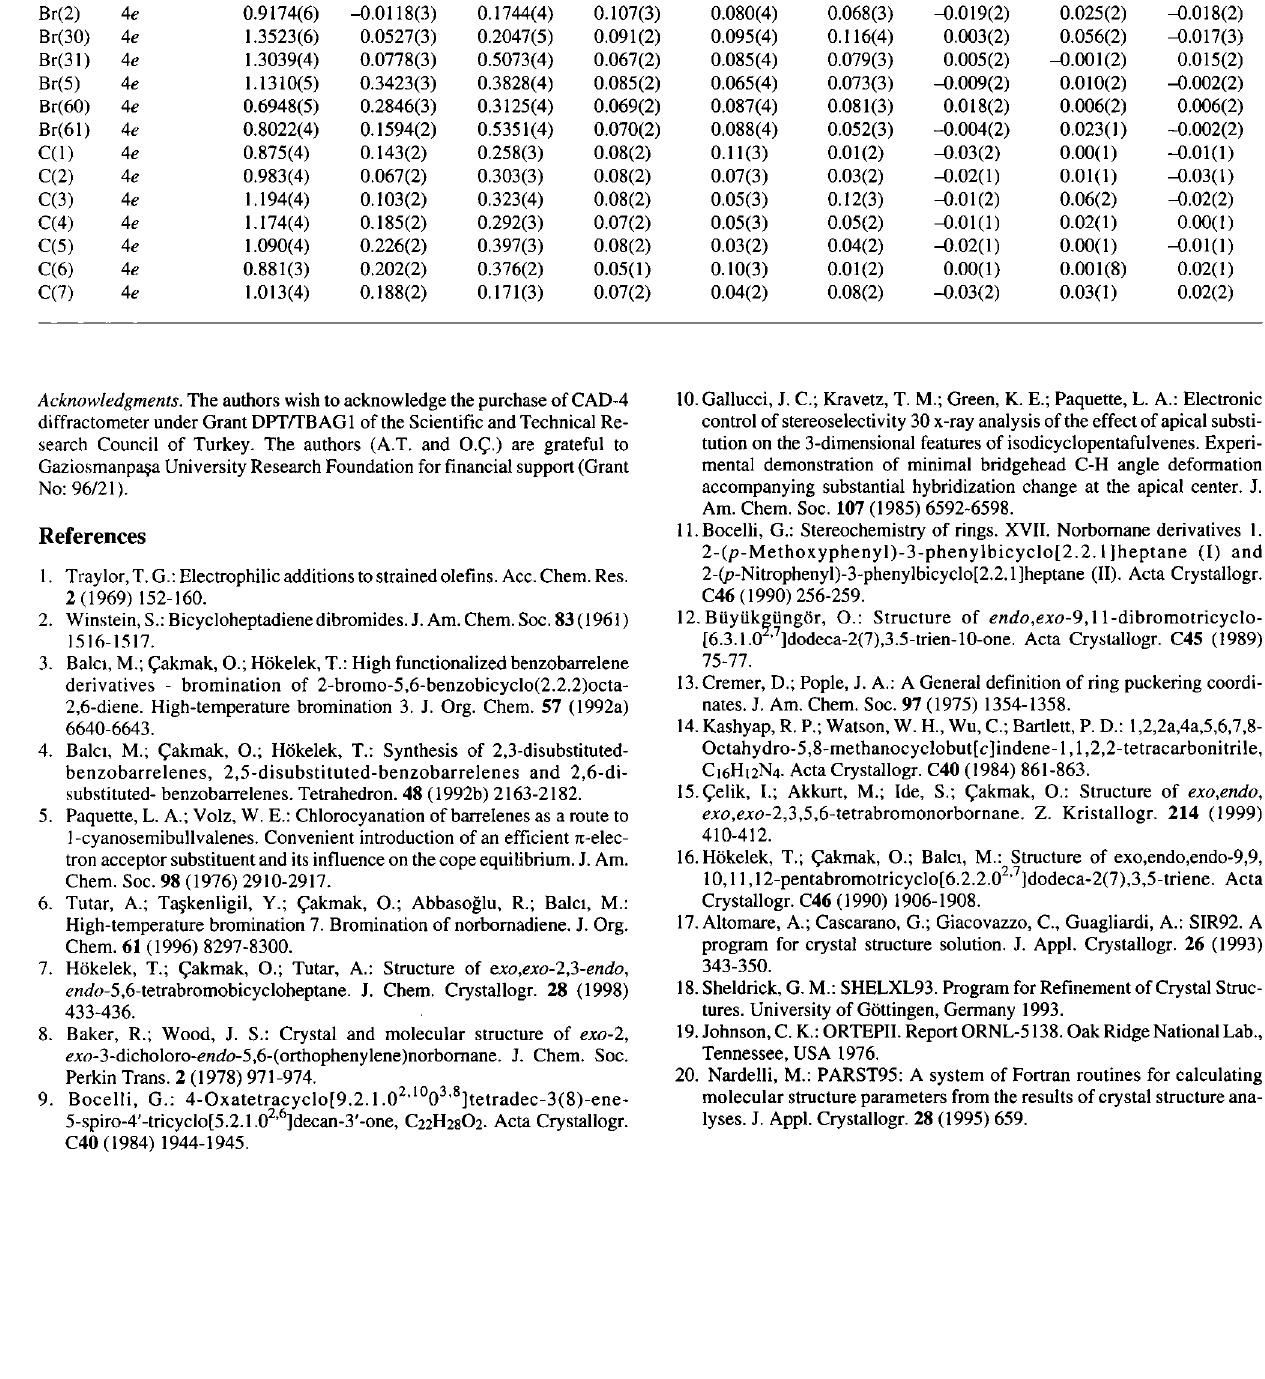
Table 3. Atomic coordinates and displacement parameters (in A 2